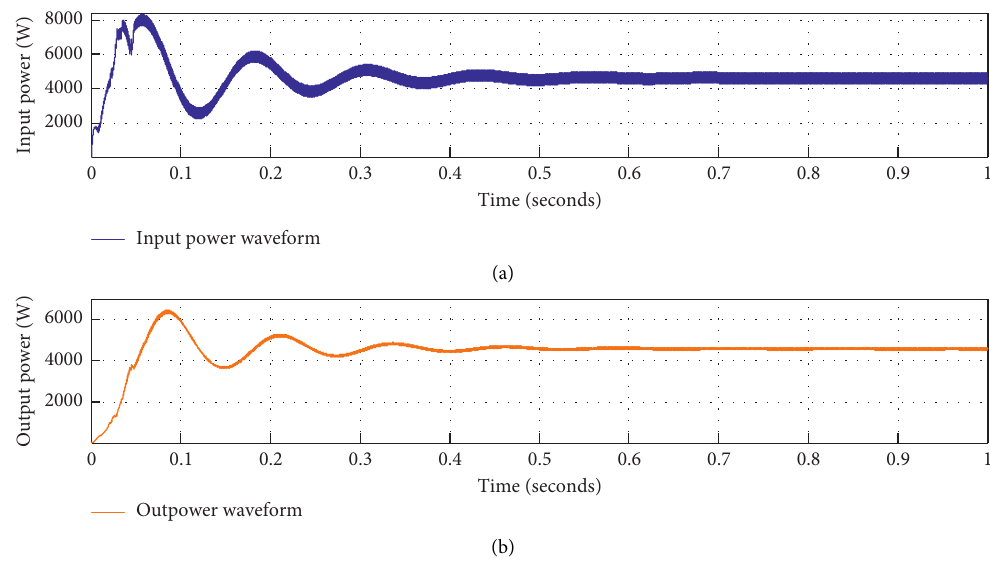
Figure 12: (a) Input power and (b) output